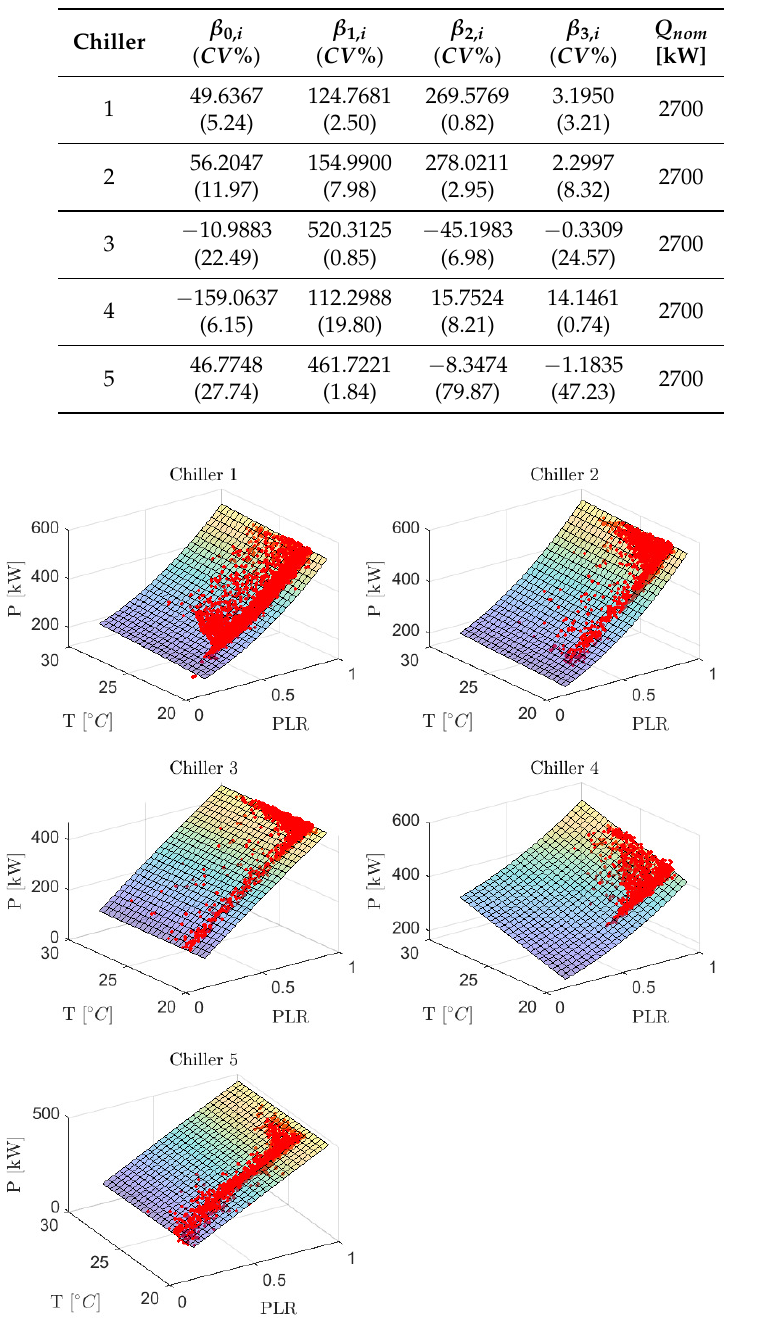
Table 6. Estimated parameters of the quadratic power consumption model (2) and corresponding CV %.